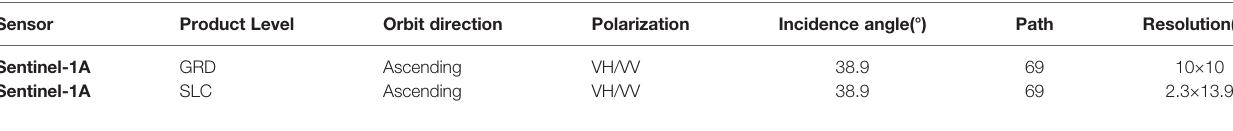
TABLE 1 | The parameters of Sentinel-1A data used for monitoring the Yellow River Delta wetlands.